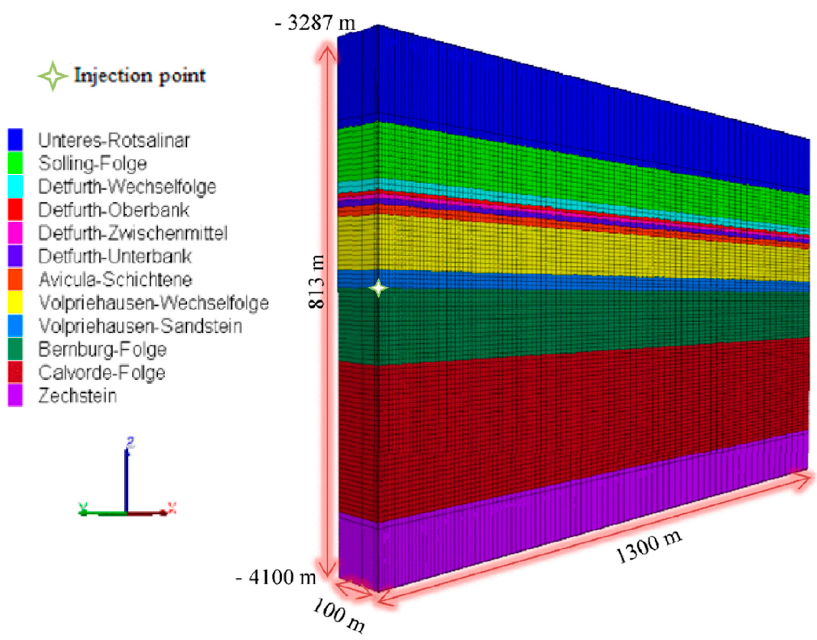
Figure 13. 3D ¼ Geometrical model of project GB X1 along with stratigraphy and injection point at volpriehausen-sandstone formation.